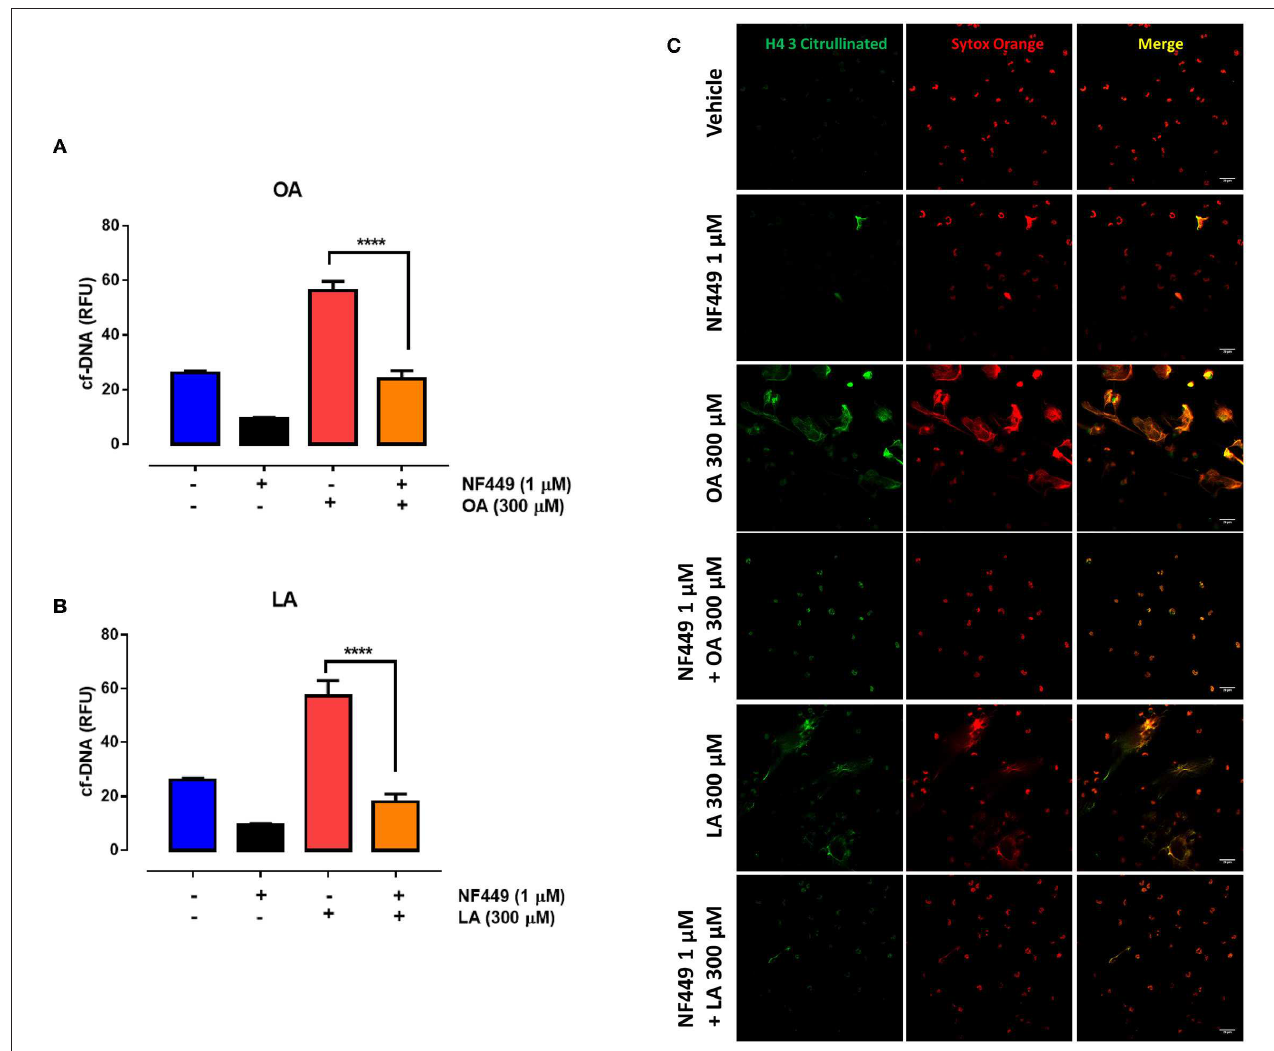
FIGURE 6 | P2X1 is involved in oleic acid (OA)-induced neutrophil extracellular trap (NET) formation. Bar graph (means ± S.E.M.) of cf-DNA of PMN treated with 1 µ M NF449 for 15min and stimulated with OA (A) or linoleic acid (LA) (B) . **** p < 0.0001 compared with OA treatment alone. Representative images from four independent experiments of PMN treated with NF449 and stimulated with OA (C) or LA (C) . n =